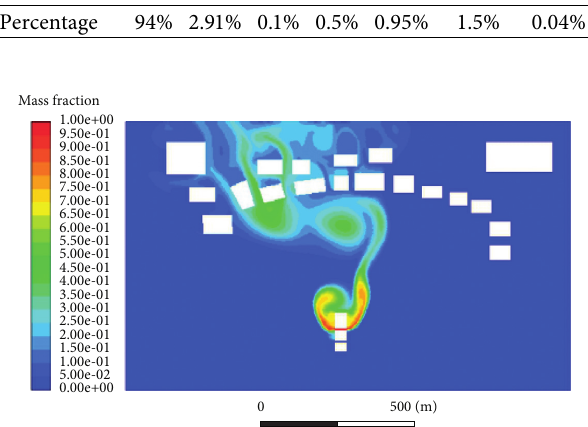
Figure 4: Radionuclide dispersion at the northern break.